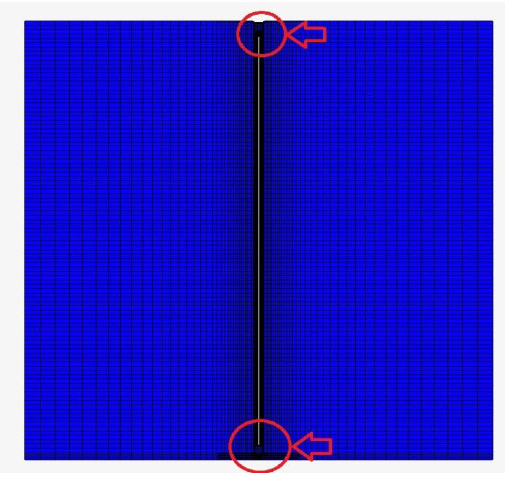
Figure 6. Two pre-welded spots inserted into the simulation model to stabilize the analysis.